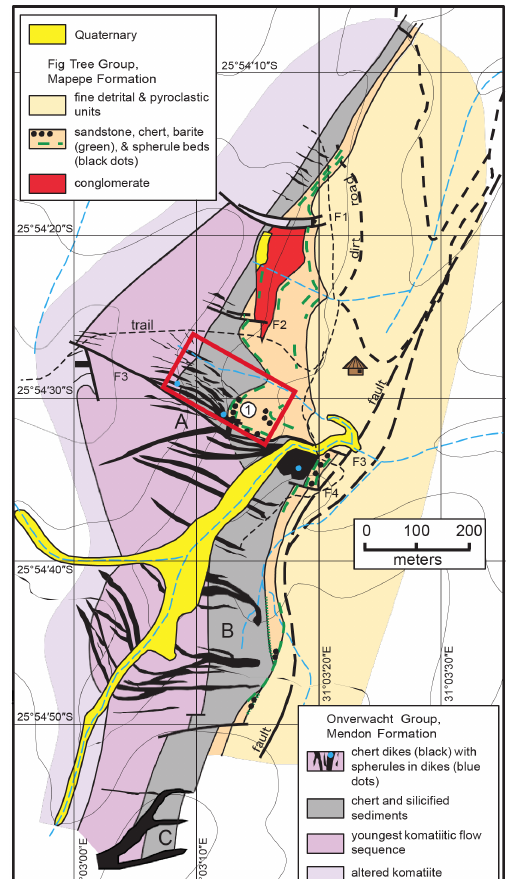
Figure 2. Geological map of the Barite Valley site from Lowe (2013) showing the repartition of the dikes (black). They start at the top of the Mendon Formation (grey) and extent downward through to the komatiitic units (pink). The red rectangle represents the studied area. Major faults are named F1 to F4.